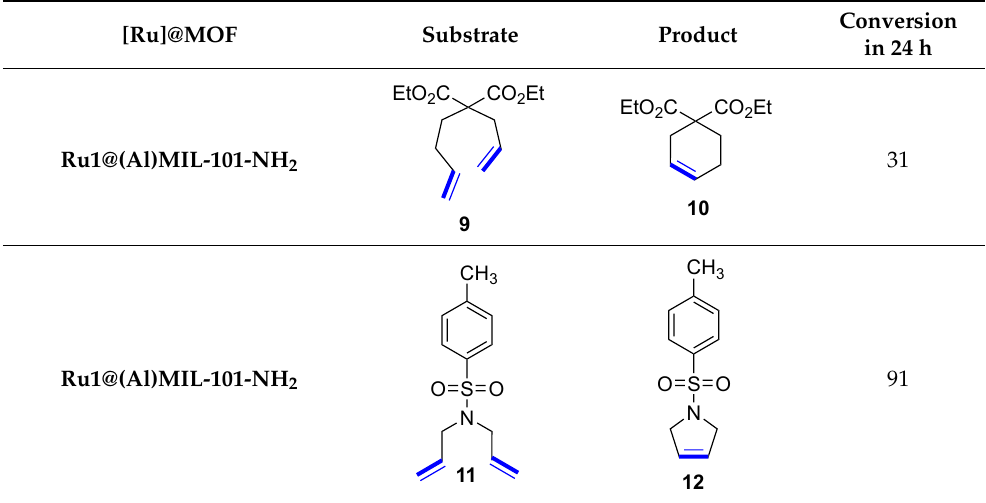
Table 3. Results of the RCM reaction of selected dienes catalysed by Ru1@(Al)MIL-101-NH 2 com- plex in toluene at 80 °C. (C [ 7 ] = 0.1 M). Conversion was determined through GC (tetradecane was used as an internal standard).